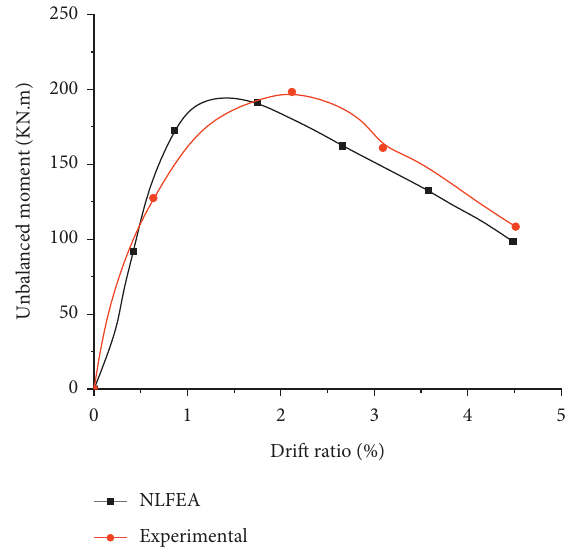
Figure 21: Unbalanced moment drift ratio graph for G6CS-2d